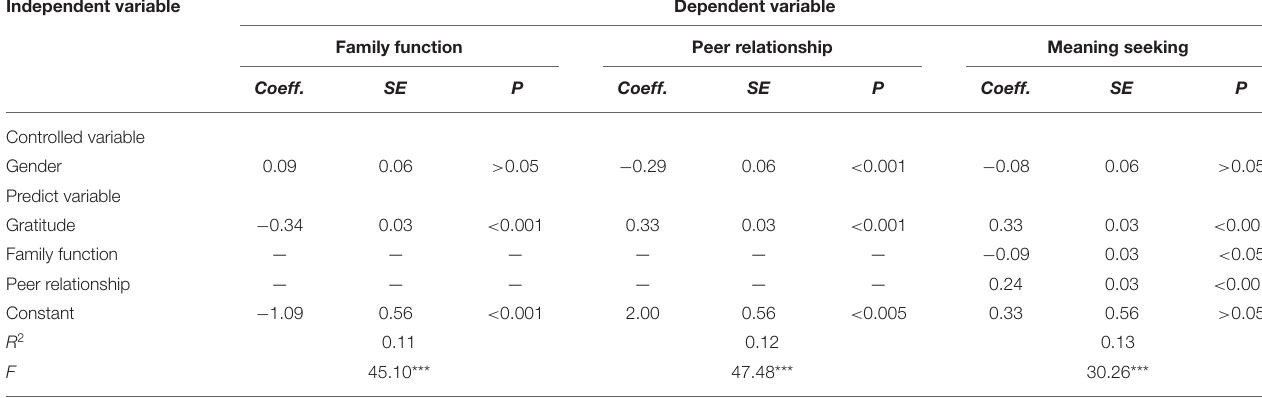
TABLE 3 | Results of PROCESS test